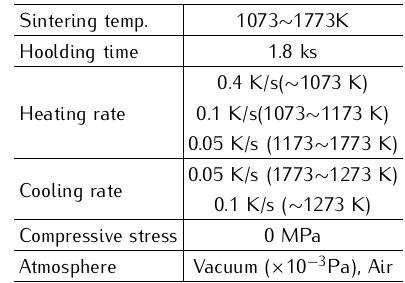
Table 1. Sintering conditions for compacts of TMA and HAp, using a resistance heating furnace. Sintering